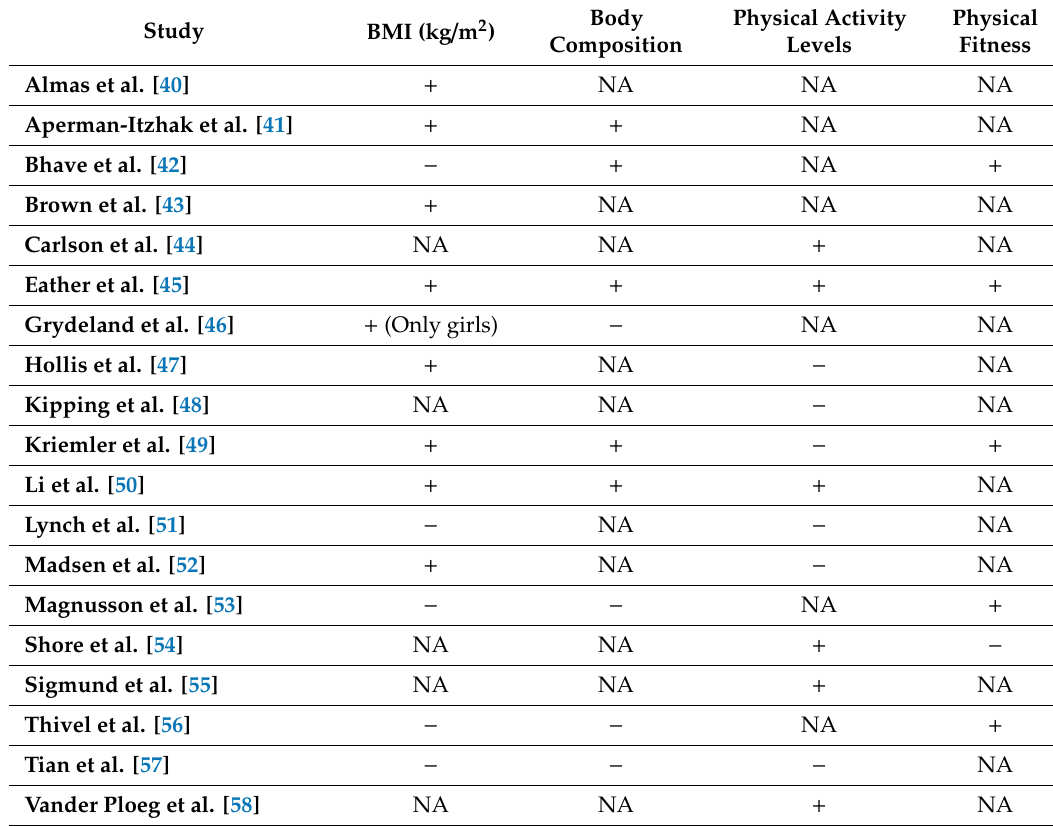
Table 3. Summary results of